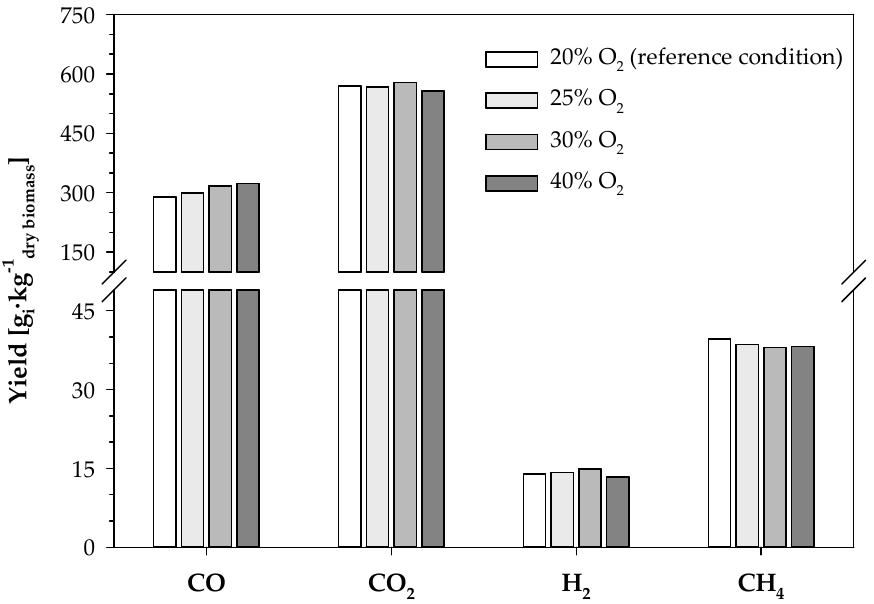
Figure 7. Effect of O 2 concentration ( φ ) in gasification agent on the CO, CO 2 , H 2 , and CH 4 yield during air gasification of RFB from eucalyptus (SBR = 0.0 kg steam ∙ kg − 1biomass —Tables 3 and 4).